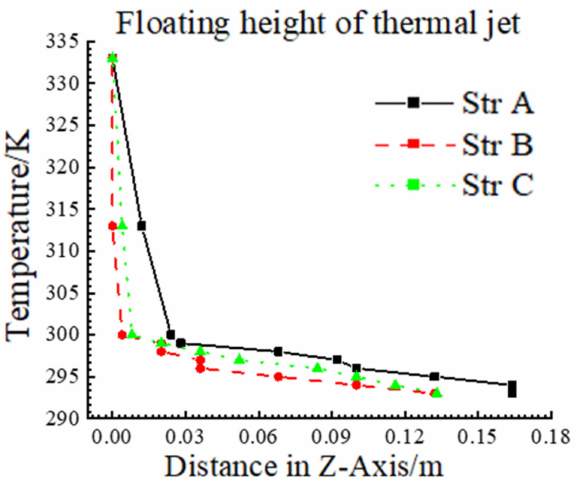
Figure 20. Floating height of the thermal jet from the discharge